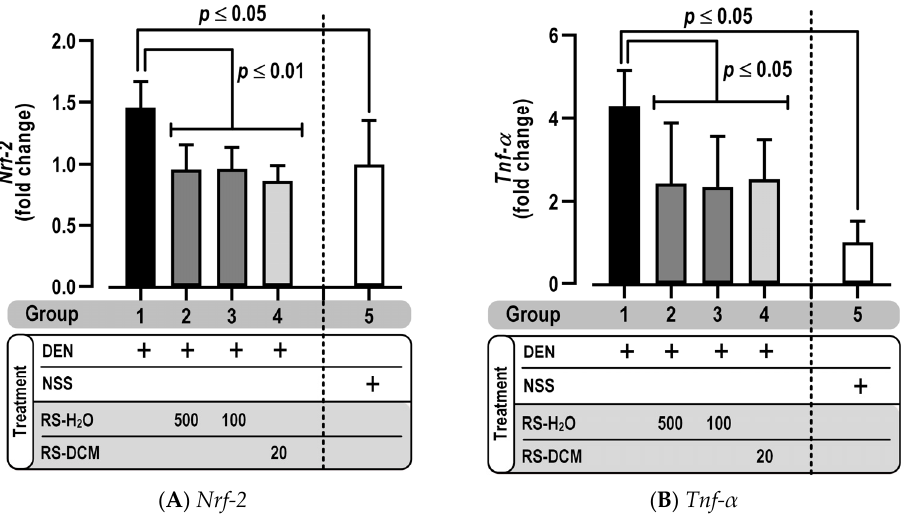
Figure 8. The e ff ect of RS on pro - in fl ammatory cytokine gene Nrf - 2 ( A ) and Tnf - α ( B ) expression . The values are expressed as mean ± SD . The data display non - normal distribution ( Shapiro – Wilk : p The values are expressed as mean ± SD. The data display non-normal distribution (Shapiro–Wilk: ≤ 0 . 05 ) and were analyzed for statistical signi fi cance using the non - parametric Mann – Whitney U p ≤ 0.05) and were analyzed for statistical significance using the non-parametric Mann–Whitney U test . RS dosage unit is mg / kg BW . test. RS dosage unit is mg/kg